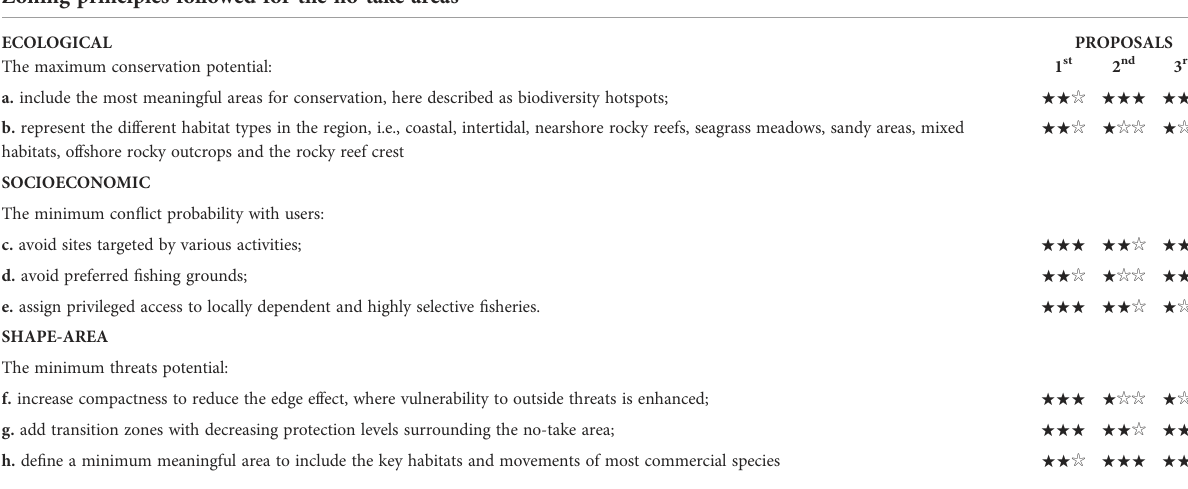
TABLE 1 Comparative analysis of the degree of compliance of zoning proposals following the pre-de fi ned zoning principles. Zoning principles followed for the no-take areas